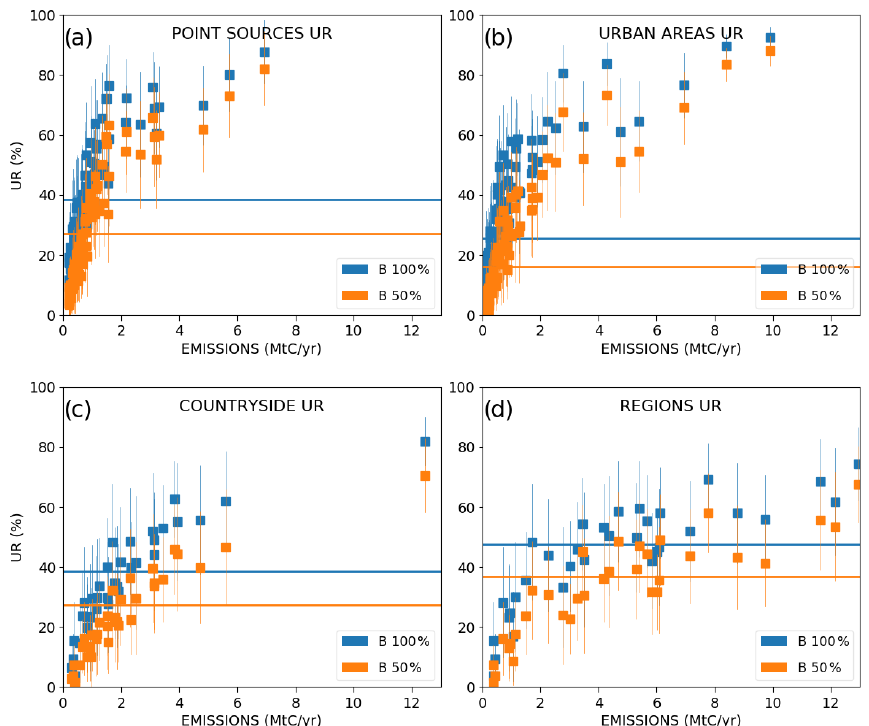
Figure 7. Mean values and standard deviations of the uncertainty reductions (UR) for the emissions of point sources (a) , urban areas (b) , countryside areas (c) , and regions (d) across the 62 inversion results for the days of March and May 2016. The lines represent the averages of the temporal mean values across all sources of a given type. The emitting areas are chosen within the 2km resolution domain of the model so that they are covered by the satellite track in order to avoid swath effects. Results are given as a function of the annual emissions ( x axis) of the emitting areas. The inversions are performed with a retrieval resolution of 2km × 2km, a precision of 0.6ppm and a swath of 900km. Prior uncertainties on the 6h budgets of the point sources, urban and countryside areas are taken to be equal to 50% (orange squares) and to 100% (blue squares). Prior uncertainties on the regional budgets are derived by aggregation of the prior uncertainties on their constituent emitting sources for both cases. Prior error correlations between hourly emissions have a temporal length of